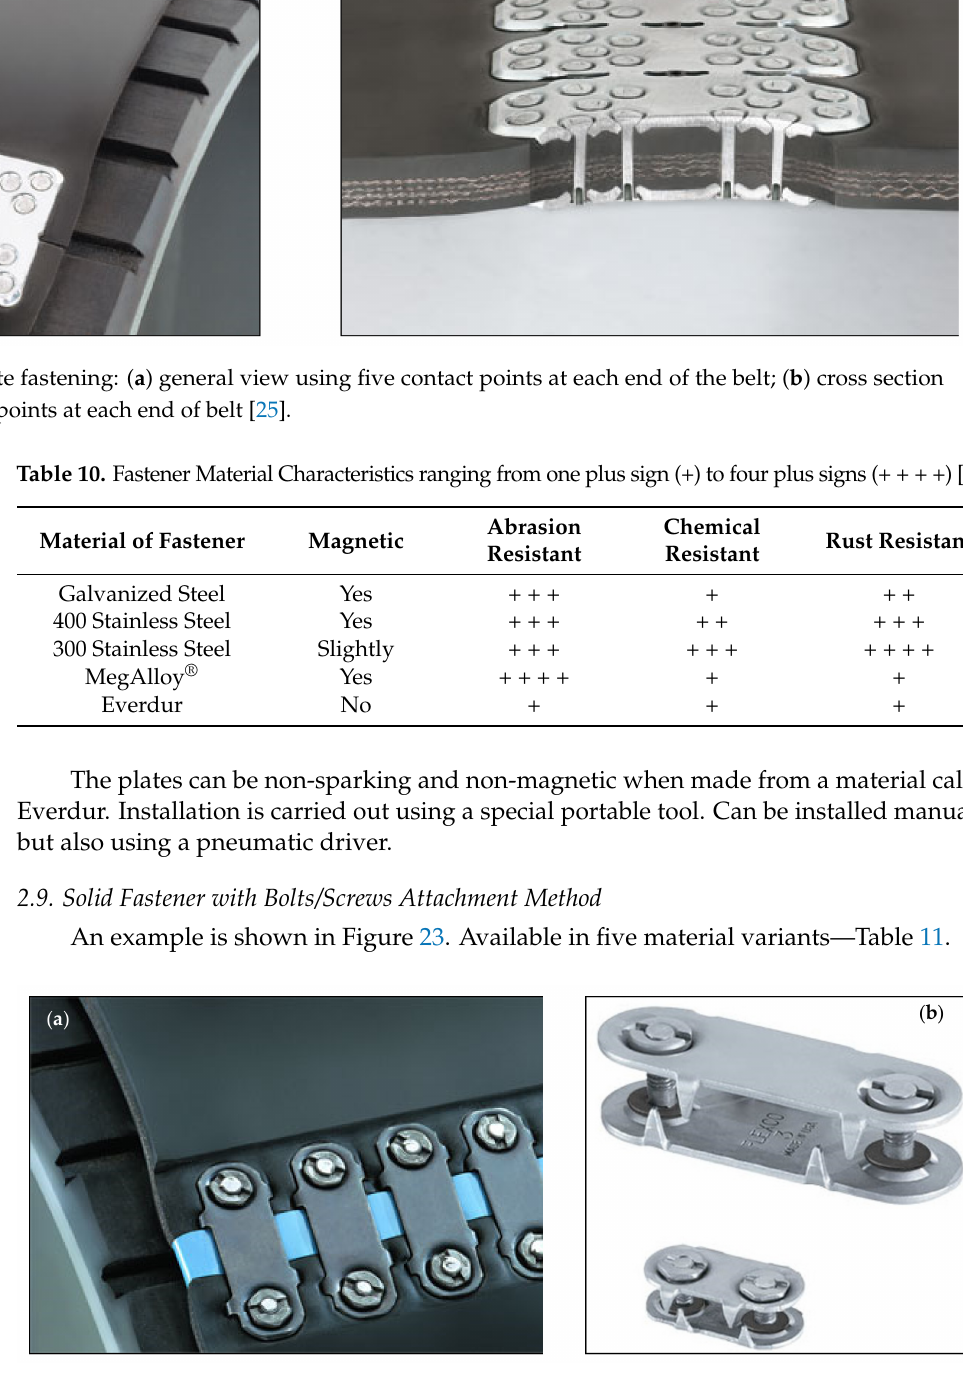
Figure 23. Bolt solid plate fastening: ( a ) general view, ( b ) single fastener